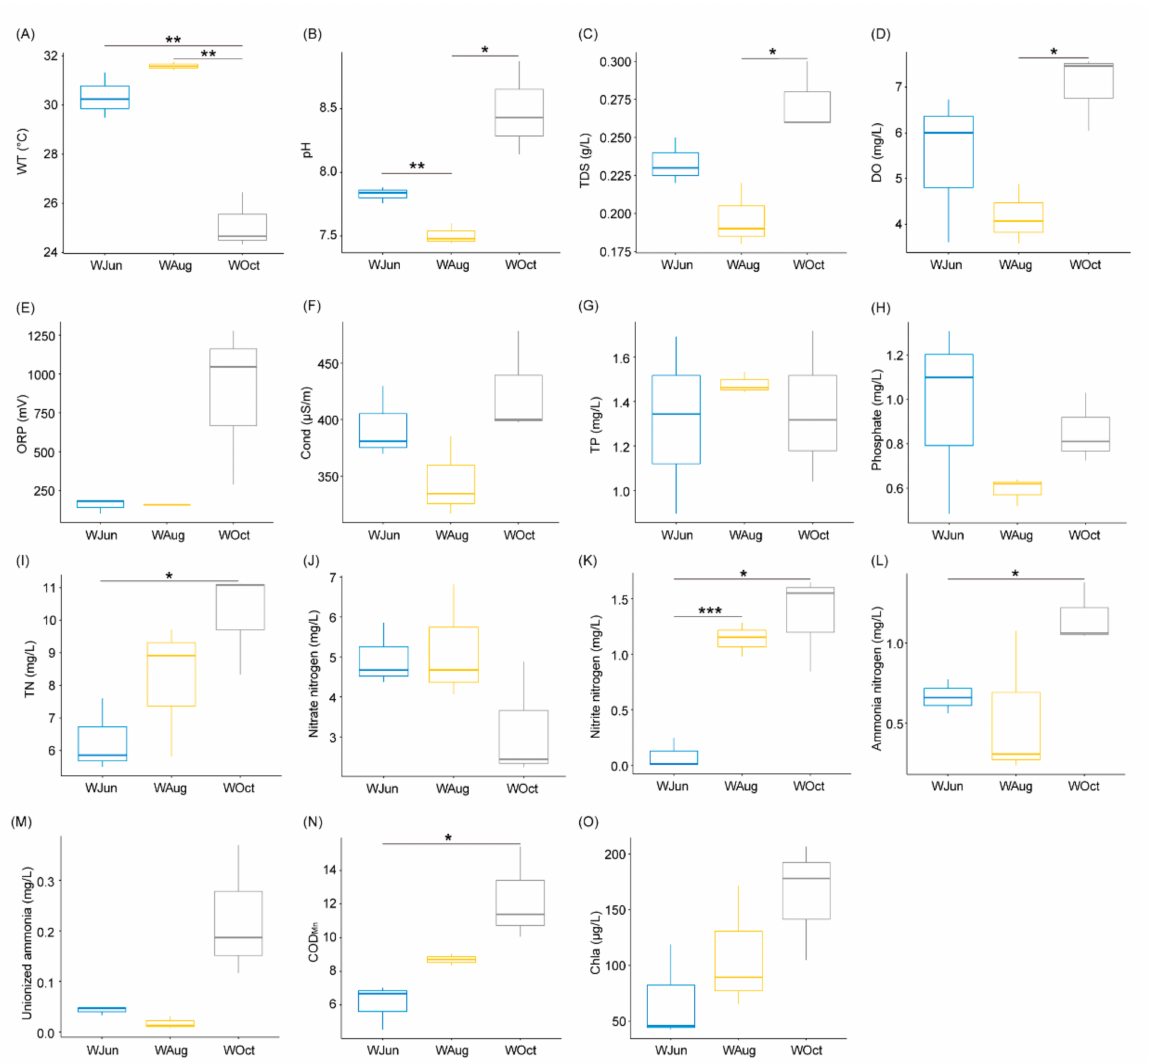
Figure 1. Water-associated physicochemical factors of aquaculture ponds. ( A ) WT, water temperature; ( B ) pH; ( C ) TDS, total dissolvable solids; ( D ) DO, dissolved oxygen; ( E ) ORP, oxidation reduction potential; ( F ) Cond, conductivity; ( G ) TP, total phosphorus; ( H ) phosphate; ( I ) TN, total nitrogen; ( J ) nitrate nitrogen; ( K ) nitrite nitrogen; ( L ) ammonia nitrogen; ( M ) unionized ammonia; ( N ) COD Mn , chemical oxygen demand; and ( O ) Chla, chlorophyll a. * p < 0.05; ** p < 0.01; *** p <